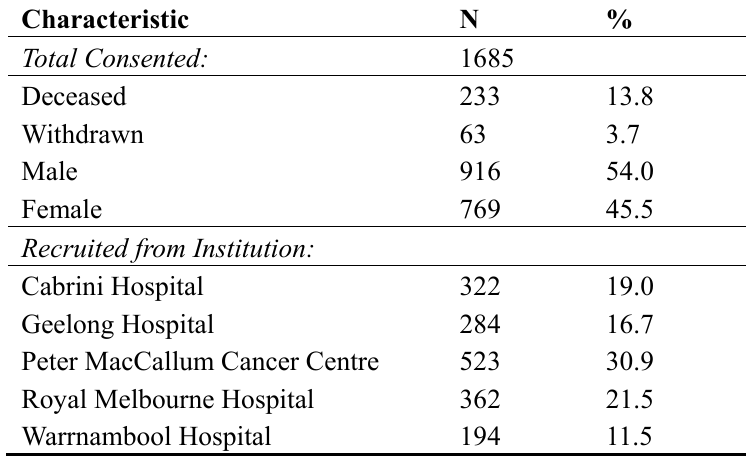
Figure 1. Schematic of pathway/protocol of patient recruitment to the cancer 2015 cohort. Table 1. Demographic characteristics of cancer 2015 cohort